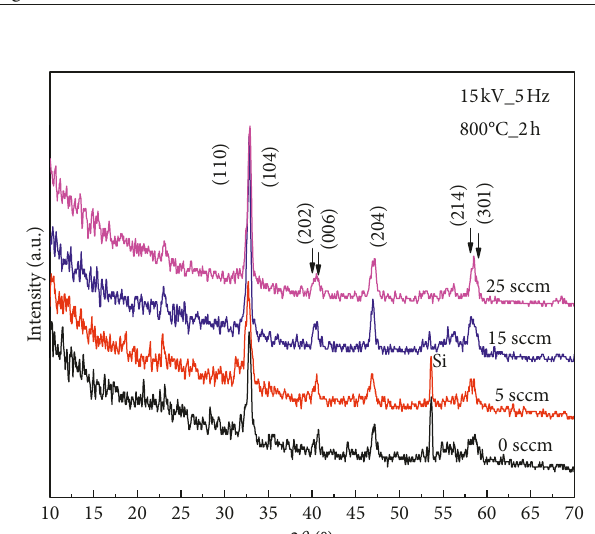
Figure 8: XRD patterns of the LaMnO 3 thin films prepared with different O 2 flux at 0, 5, 15, and 25 sccm after annealing at 800 ° C for 2h.